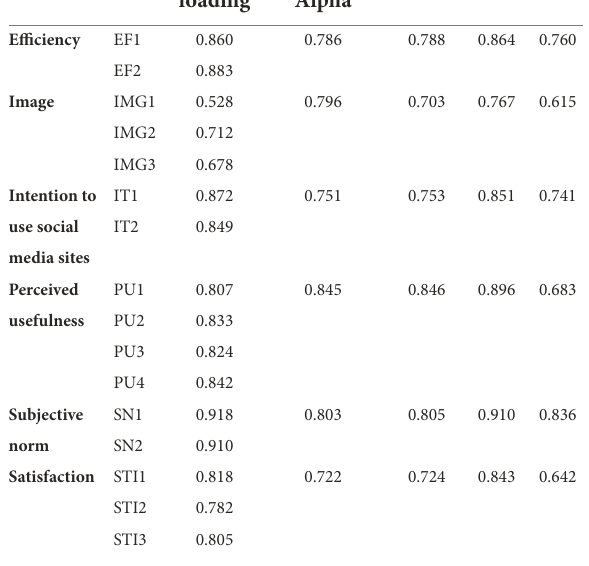
indicates a suitable model prediction. Table 4 shows that all exogenous constructs have R Square values better than 0.613, which indicates a significant predictive accuracy for the model (Hair et al., 2016a,b).